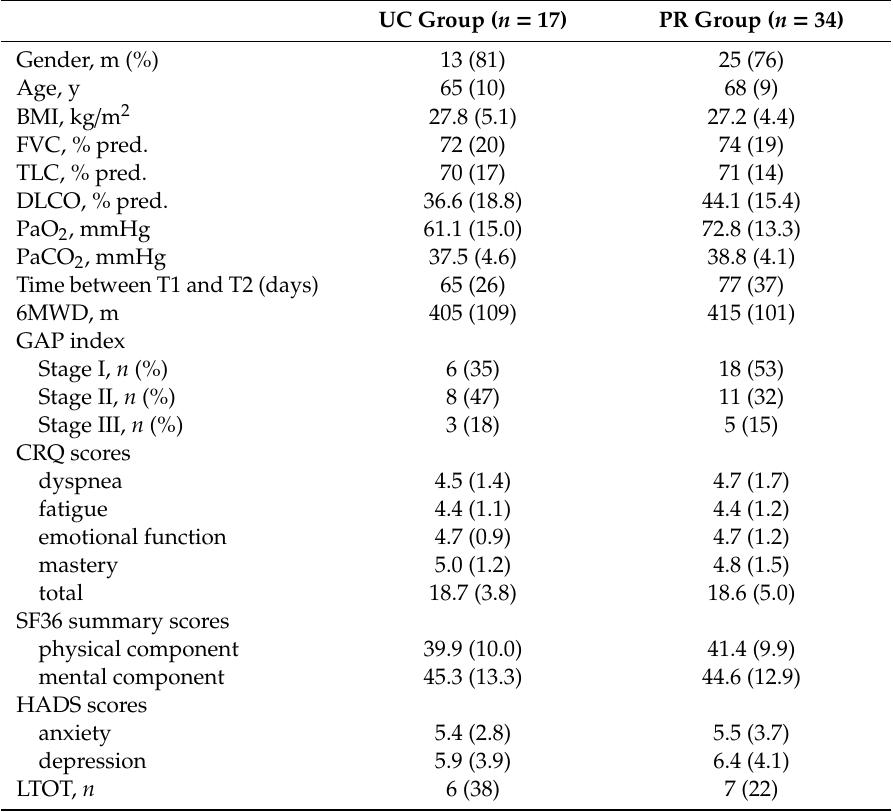
Table 1. Baseline